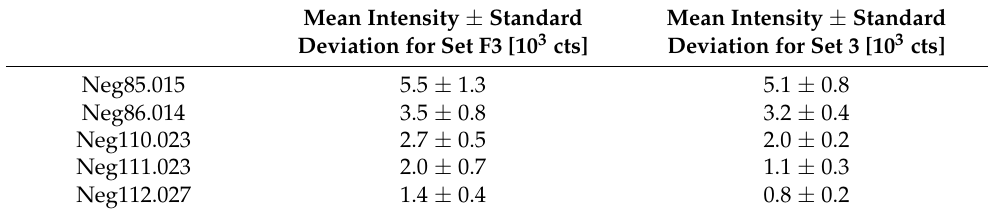
Table 2. Signal intensities of highly correlated unassigned peaks from n-TiO 2 ⊂ sunscreen